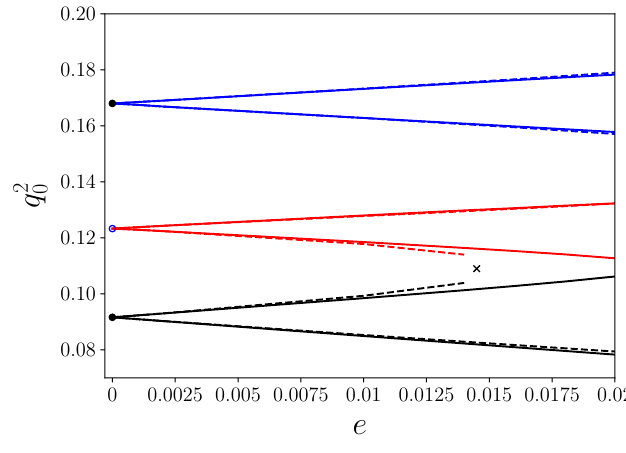
Figure 8 . Qualitative structure of the energy levels in the external field. The levels at e = 0 are denoted by black filled dots. These are split when e 6 = 0 . There are additional levels (red curves) that do not have counterparts at e = 0 . On the figure, they emanate from the empty blue dot. The solid and dotted lines denote the “exact” and “perturbative” solutions, respectively, depending on the use of the “exact” and “perturbative” expressions for the loop function. The approximate location where two “perturbative” levels merge and disappear is marked by a cross.